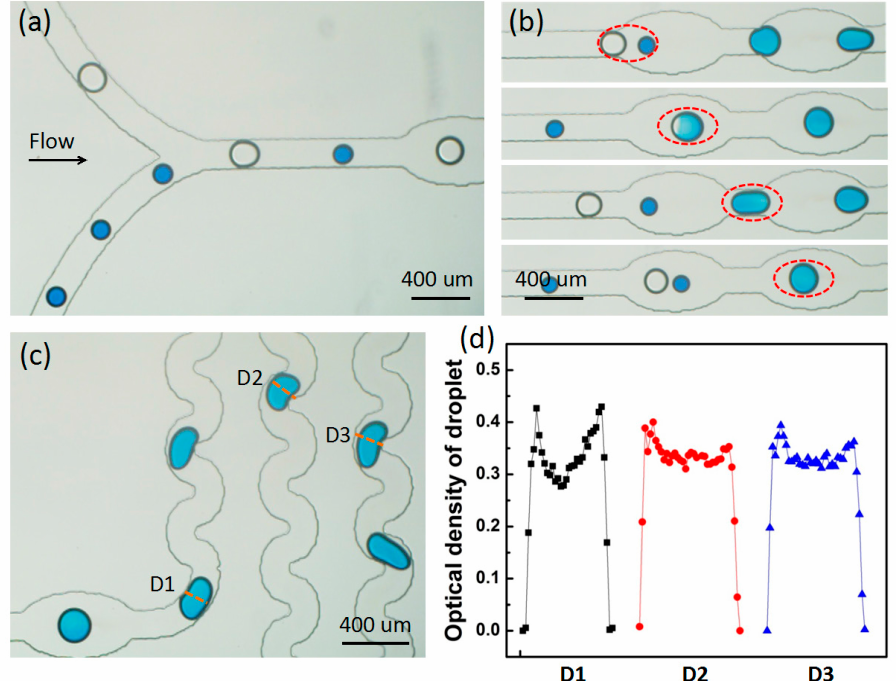
Figure 3. Droplets were ( a ) merged in the Y-shape channel and ( b ) collided in the inflated elliptical chambers and ( c ) mixed in the following S-shape channel and ( d ) The optical density analysis of the merging droplets from D1 to D3 in the mixing channel with the same mixing ratio.